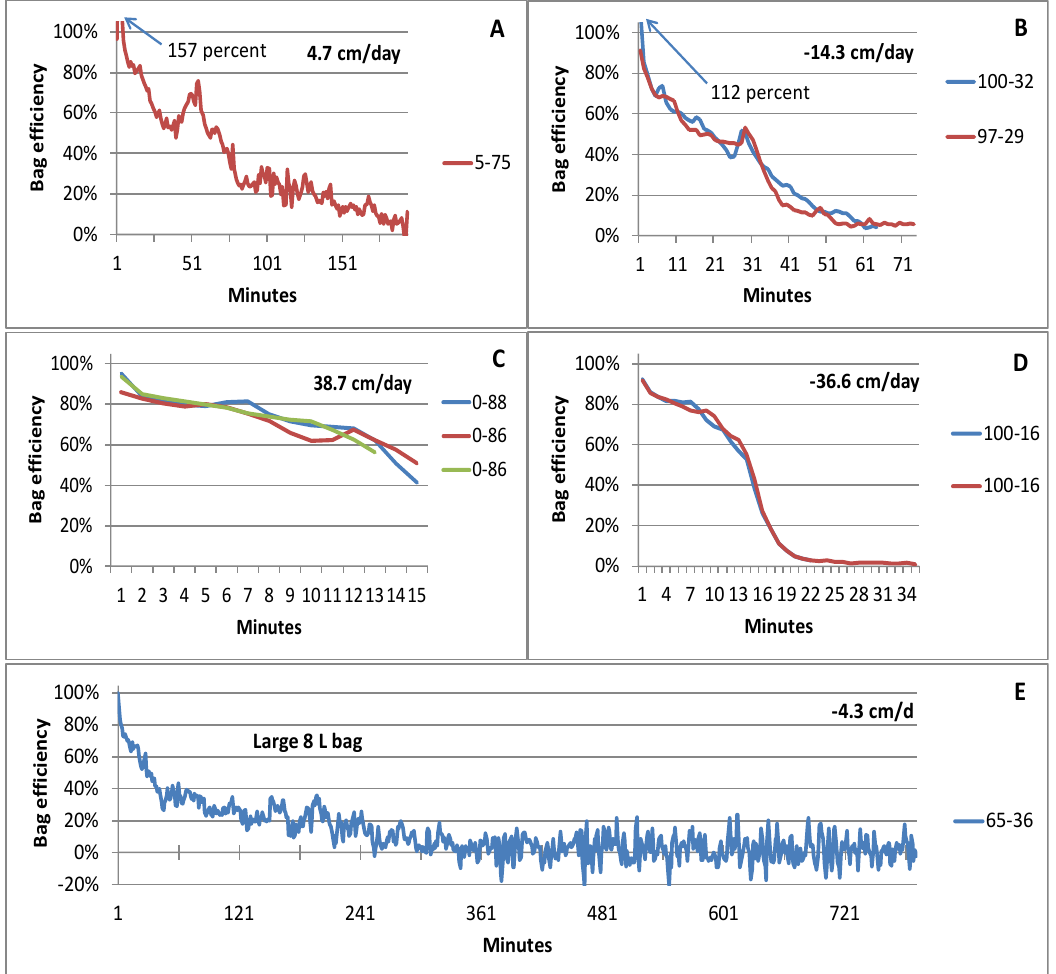
Figure 5. Seepage bag efficiency for long-duration bag connection times. Panels ( A , C ) show upward seepage (empty-to-full bag connections) and ( B , D ) downward seepage (full-to-empty bag connections). Panel ( E ) is a large-volume seepage bag. Legend entries indicate beginning and ending percent bag fullness. Values in bold in each chart are seepage rates through the ESM (cm / d) in between bag attachments.